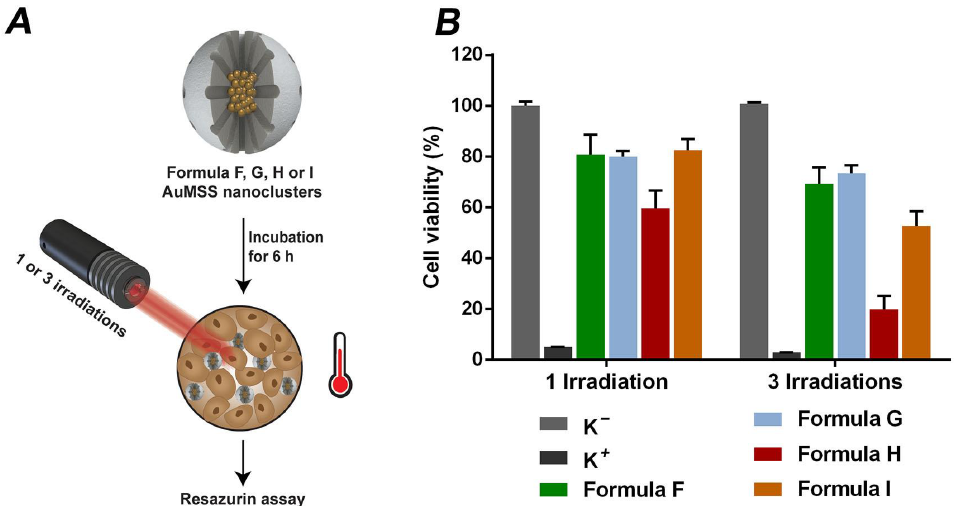
Figure 5. AuMSS nanoclusters cytotoxic profile towards HeLa cells. ( A ) Schematic representation of AuMSS nanoclusters cytotoxic activity upon NIR irradiation (808 nm, 1.7 W cm −2 , 5 min); ( B ) Cytotoxic activity of different nanoclusters at 200 µg/mL with 1 and 3 laser irradiations.